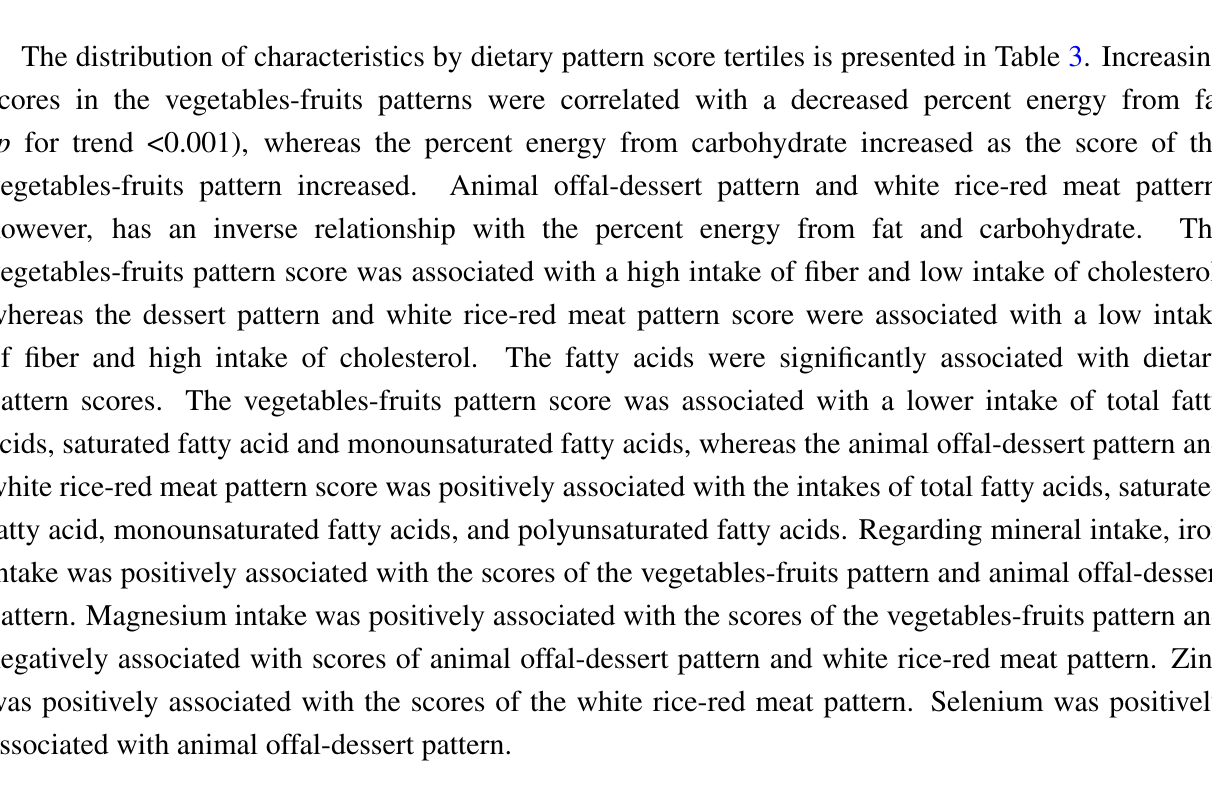
Table 3. Distribution of characteristics by the tertiles of dietary pattern